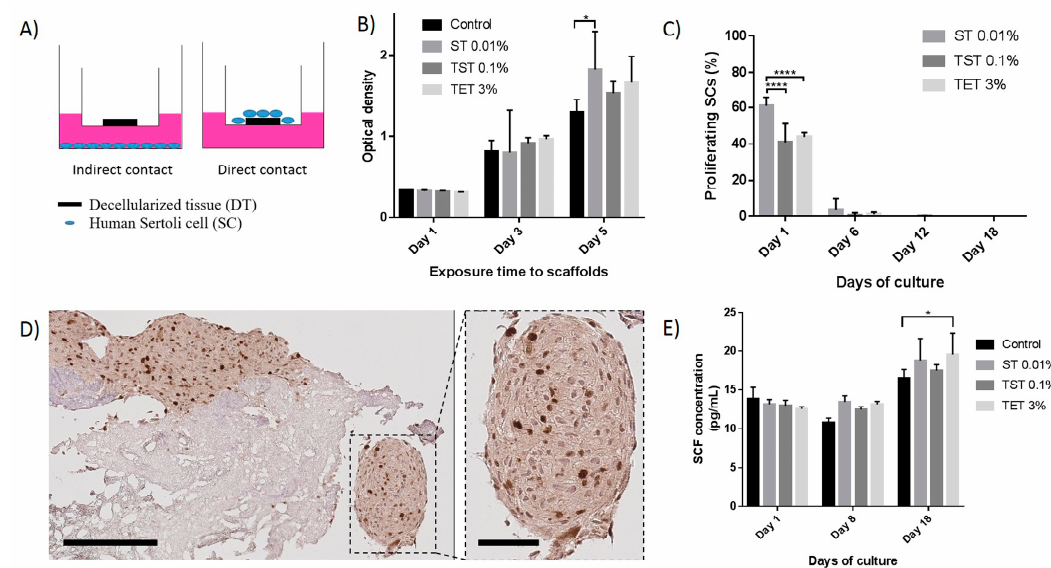
Figure 7. Effects of DTs on proliferation and functionality of SCs. ( A ) Representative drawing of direct and indirect contact culture systems. The indirect contact culture system was used for the WST-1 assay; ( B ) Proliferation of SCs seeded in the compartment below the transwell containing DTs evaluated using the WST-1 assay which is based on the reduction of a tetrazolium salt to a soluble violet formazan product by viable cells. Optical density, which is proportional to cell numbers/well, was recorded on days 1, 3 and 5 using a spectrophotometer; ( C ) Percentage of proliferative SCs seeded onto DTs on days 1, 6, 12 and 18 of culture. SCs seeded onto ST 0.01% DTs present a higher percentage of proliferation compared to TST 0.1% and TET 3% DTs on day 1; ( D ) Immunohistochemical staining of Ki67 in SCs seeded onto DT. The enlarged image shows a round shaped structure as observed in some cases. Scale bares = 200 and 60 µ m; ( E ) SCs seeded onto DTs secreted at least the same amount of SCF than SCs seeded alone. Results are presented as mean ± SD. * p < 0.05, **** p < 0.0001.